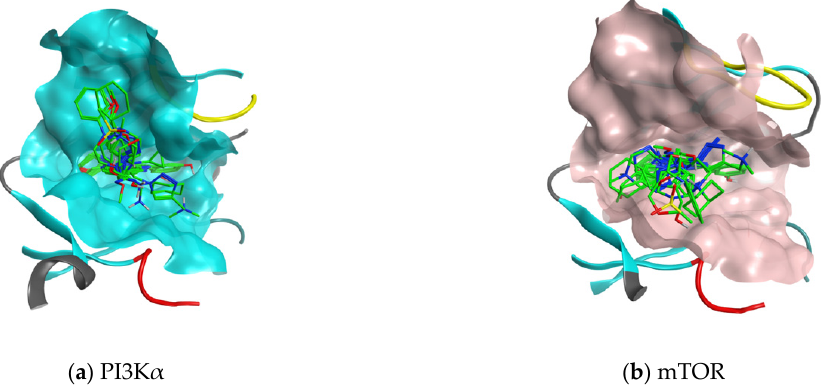
Figure 3. Superimposition of all the best docking poses of all compounds in PI3K α ( a ) and mTOR ( b ).